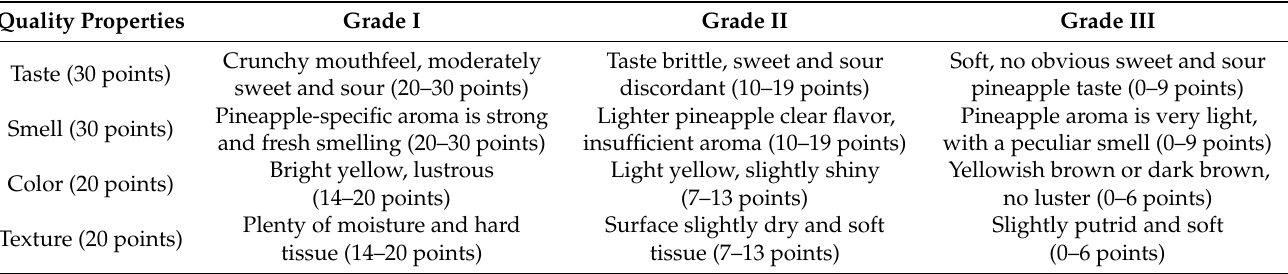
Table 1. Evaluation criteria for freshly cut pineapple sensory